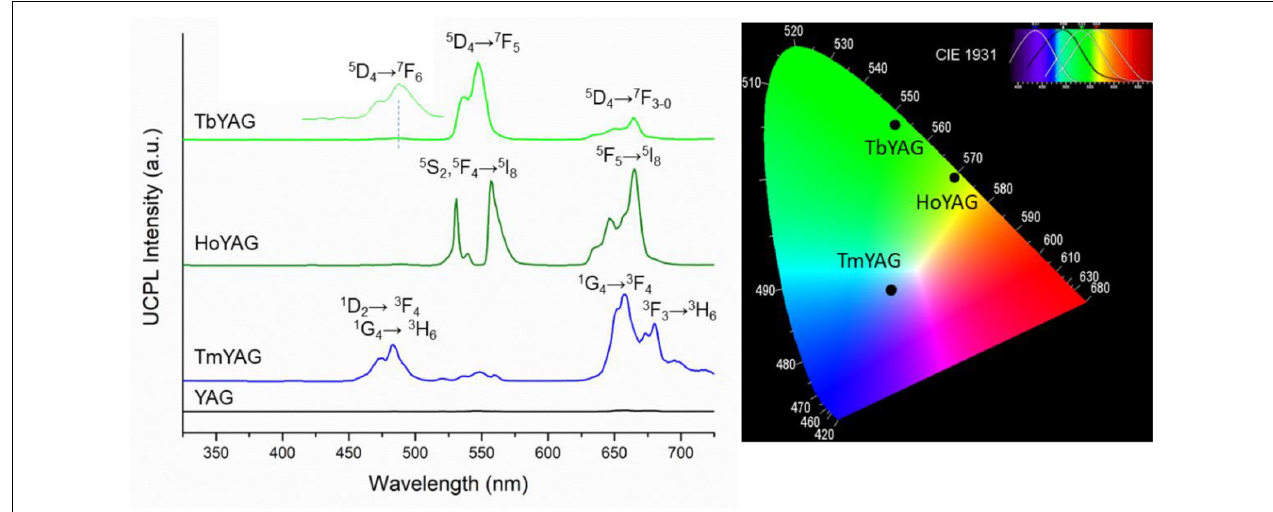
FIGURE 4 | Up-conversion photoluminescence of the undoped and lanthanide-doped YAG samples annealed at 1200 ◦ C ( λ exc = 980 nm). CIE chromaticity diagram of the doped garnets.